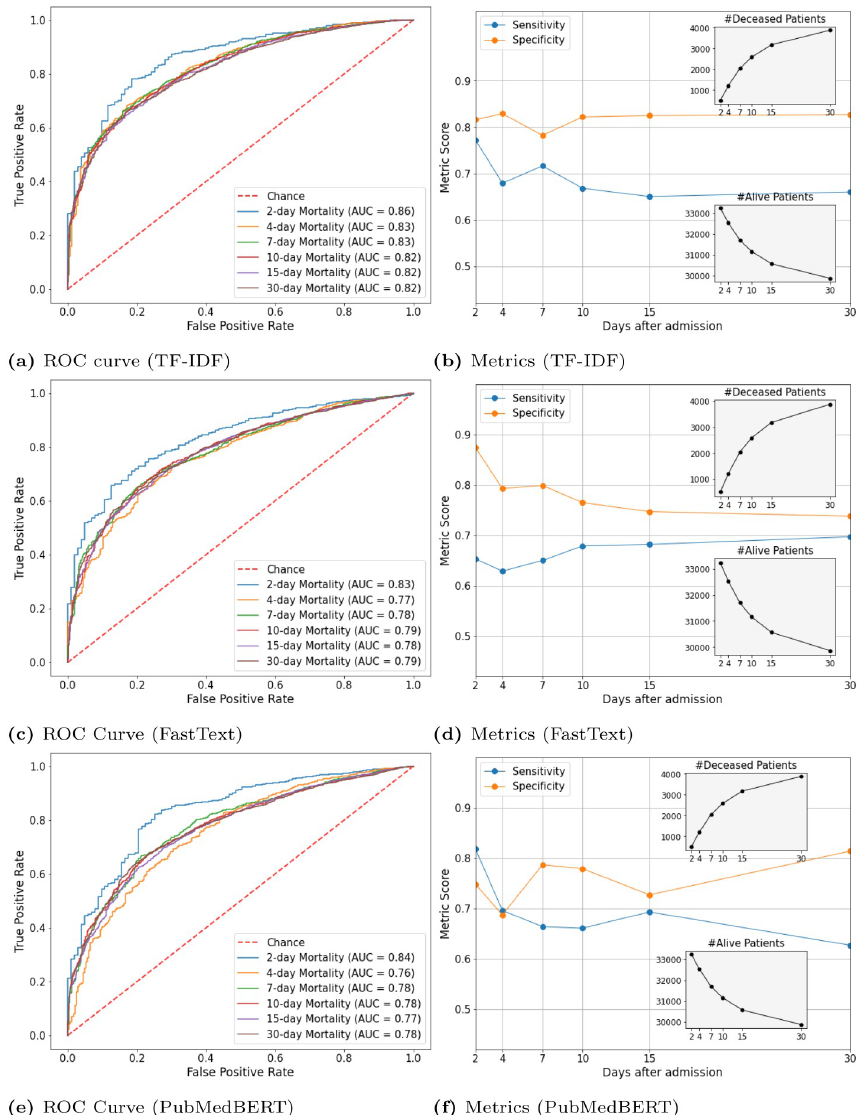
Fig 6. Test ROC curve, AU-ROC score, sensitivity and specificity scores for logistic regression model with TF-IDF, FastText, and PubMedBERT. The optimum threshold value for sensitivity and specificity scores has been calculated using Youden’s Index. The x-axis represents the prediction window. The grey boxes show the number of deceased and alive patients with respect to the prediction windows.